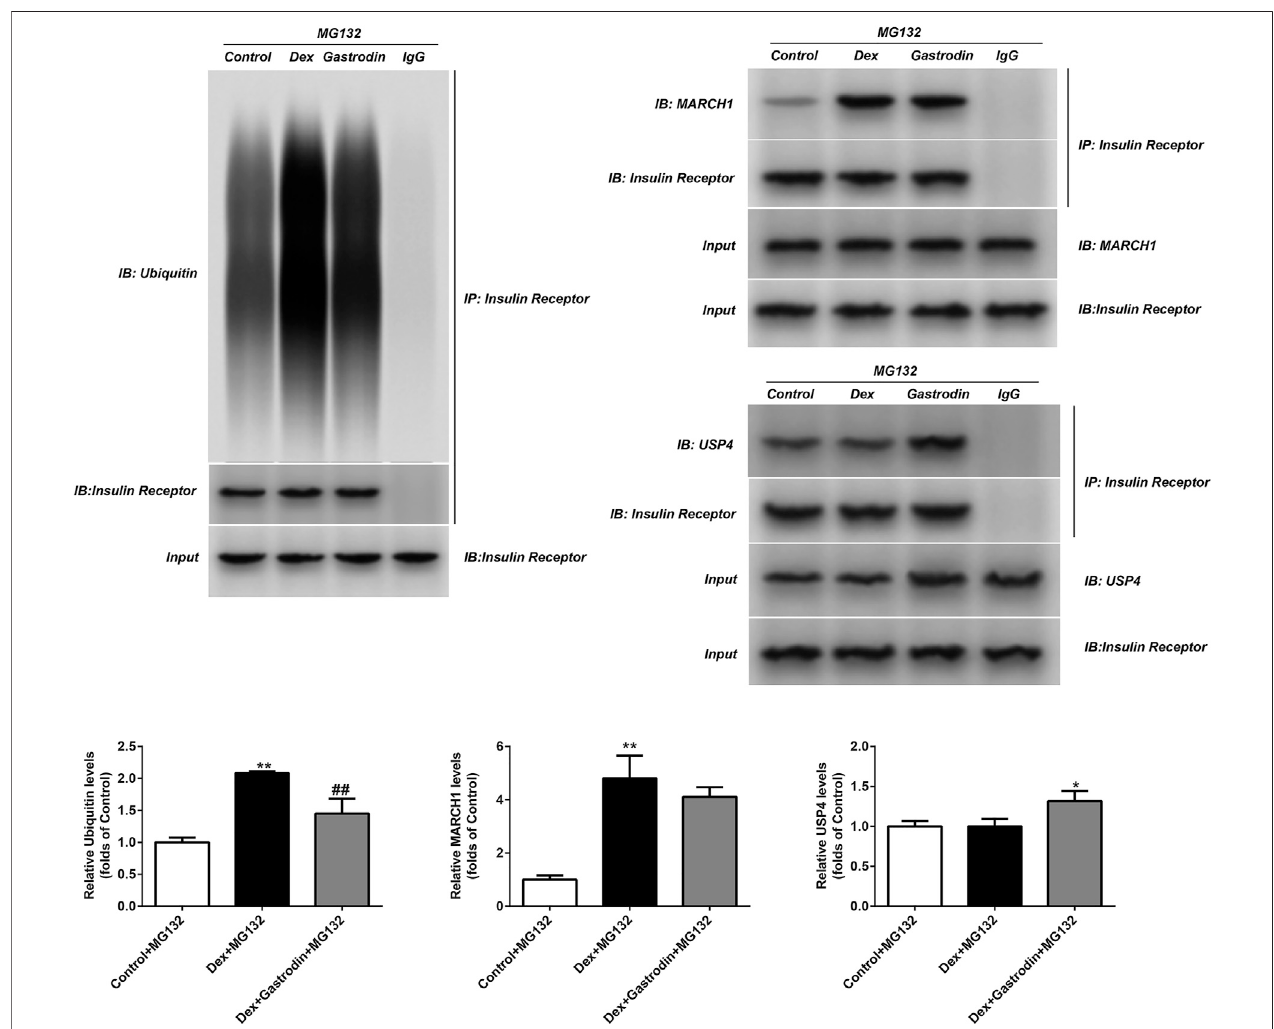
FIGURE10| Theubiquitinlevelofinsulinreceptor andlevelsofMARCH1,USP4andinsulinreceptorweremeasured withCo-IP( n (cid:1) 3).MG132wasaproteasome inhibitor. The concentration of gastrodin was 100 μ M. * p < 0.05, ** p < 0.01, vs. control+MG132 group, ## p < 0.01, vs. Dex+MG132 group.